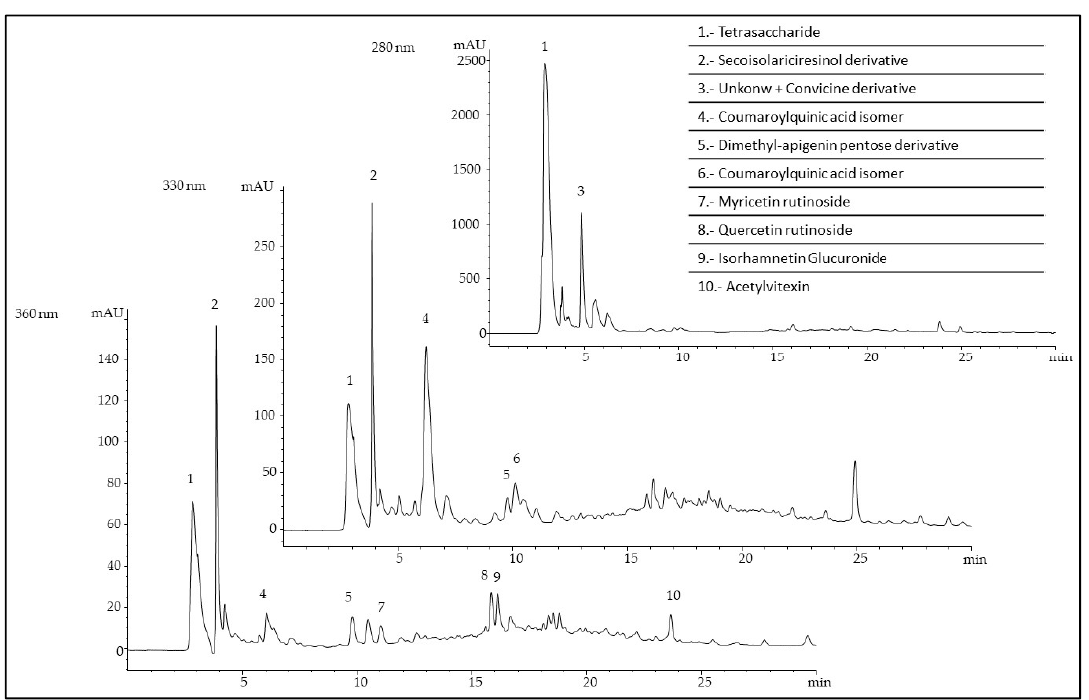
Figure 3. Chromatograms of the phenolic profile of the pulse Vicia narbonensis as detected at three wavelengths, 260, 280, and 330 nm.